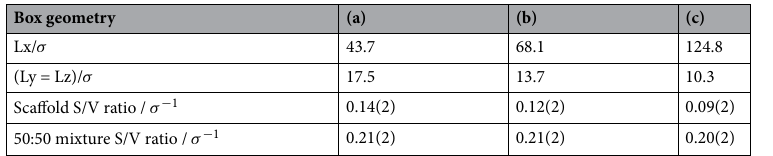
Table 1. Simulation box dimensions and condensate surface/volume ratios (S/V) of the three box geometries represented in Fig. 2 for the pure scaffold system and the 50:50 binary mixture of scaffold and surfactant